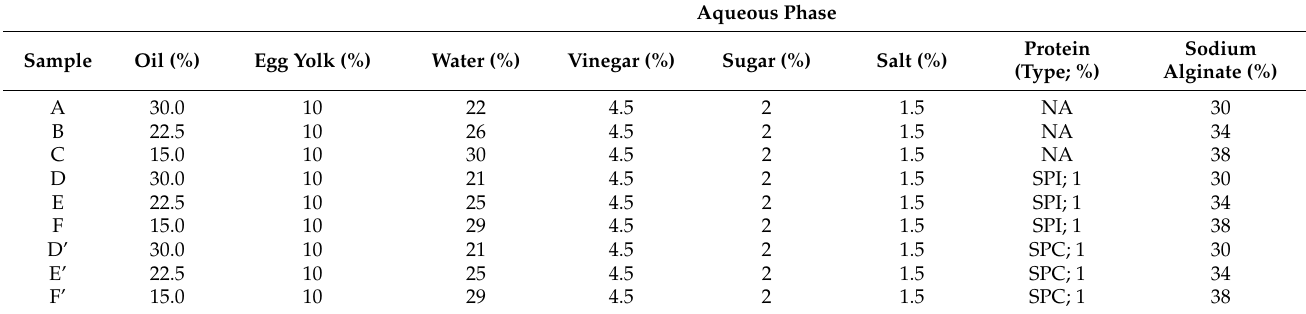
Table 1. The concentration of the ingredients in the low-fat